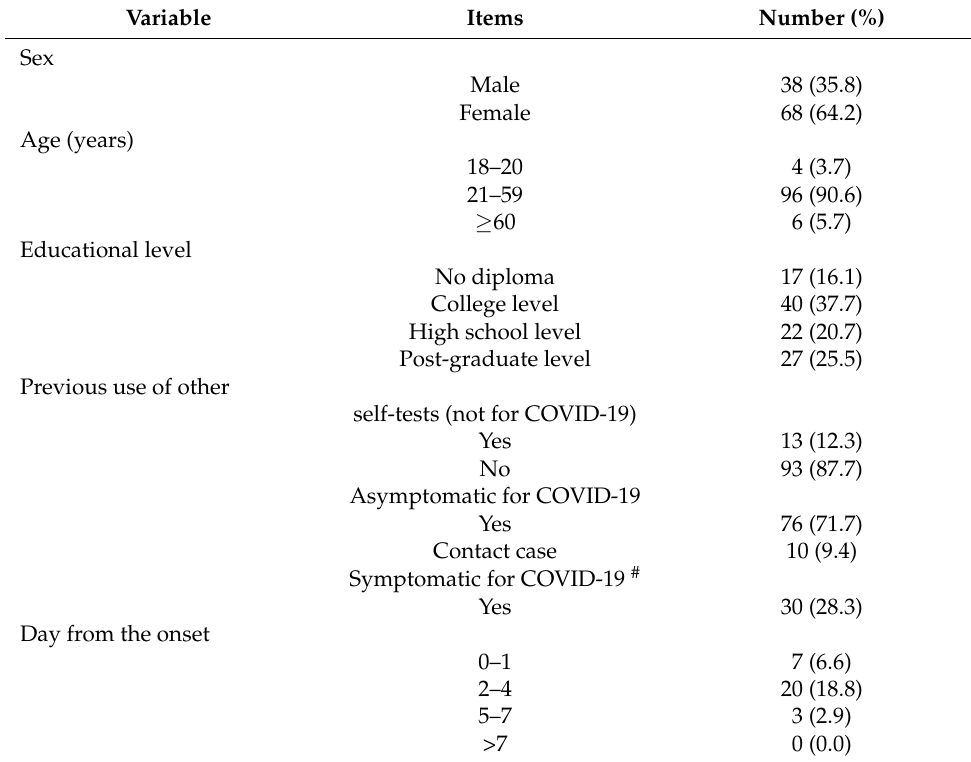
Table 1. Demographic characteristics and medical history of the 106 study